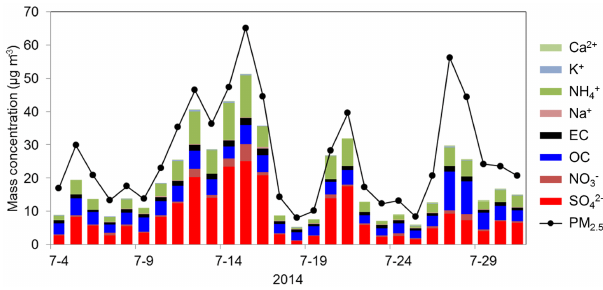
Figure 2. Temporal variations in the chemical components of fine particulate matter (PM 2 . 5 ) at the Daejeon site during July